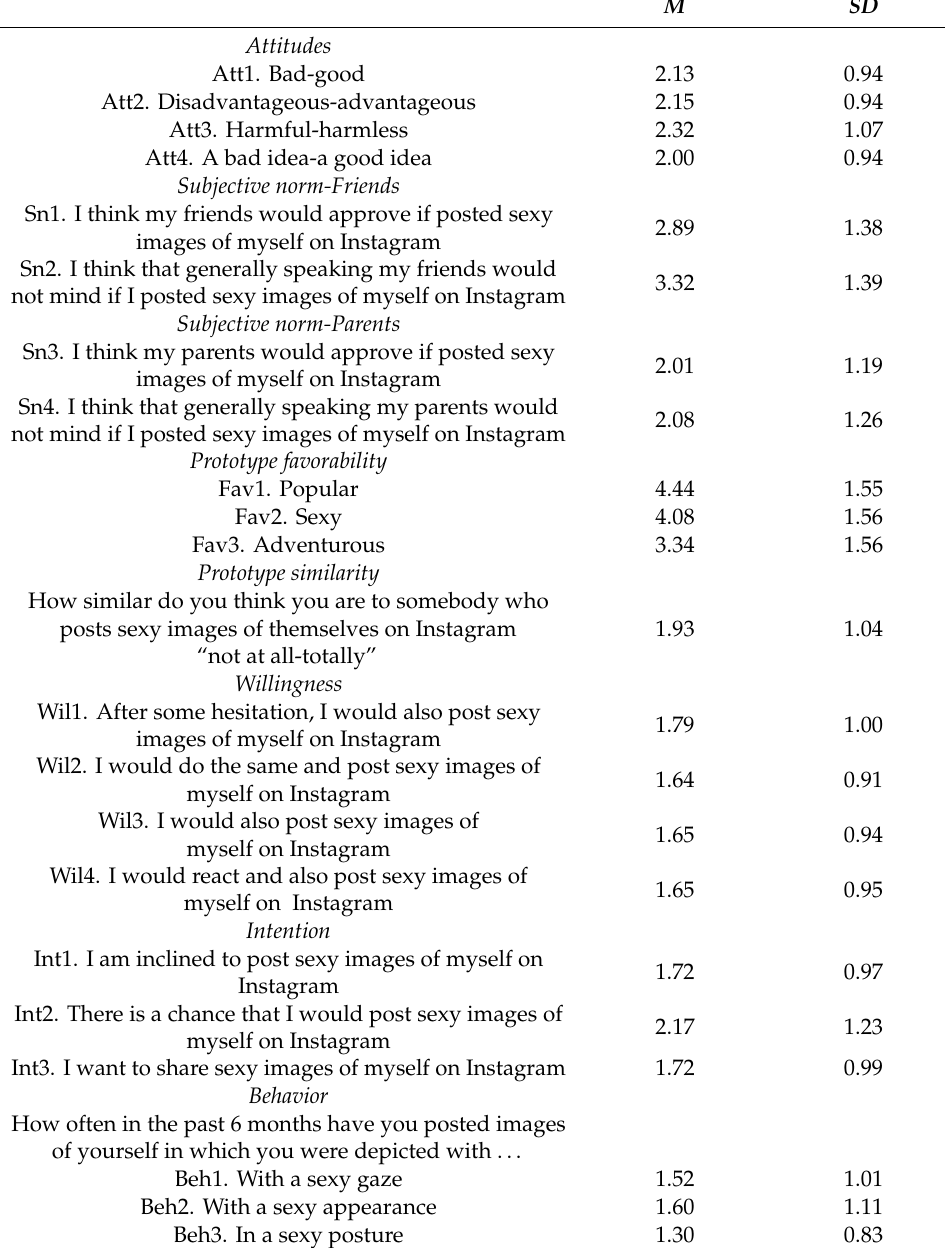
Table 1. Descriptions of the study